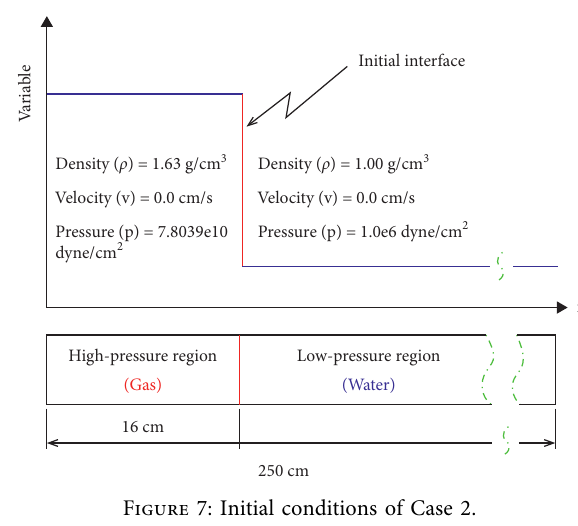
Figure 7: Initial conditions of Case